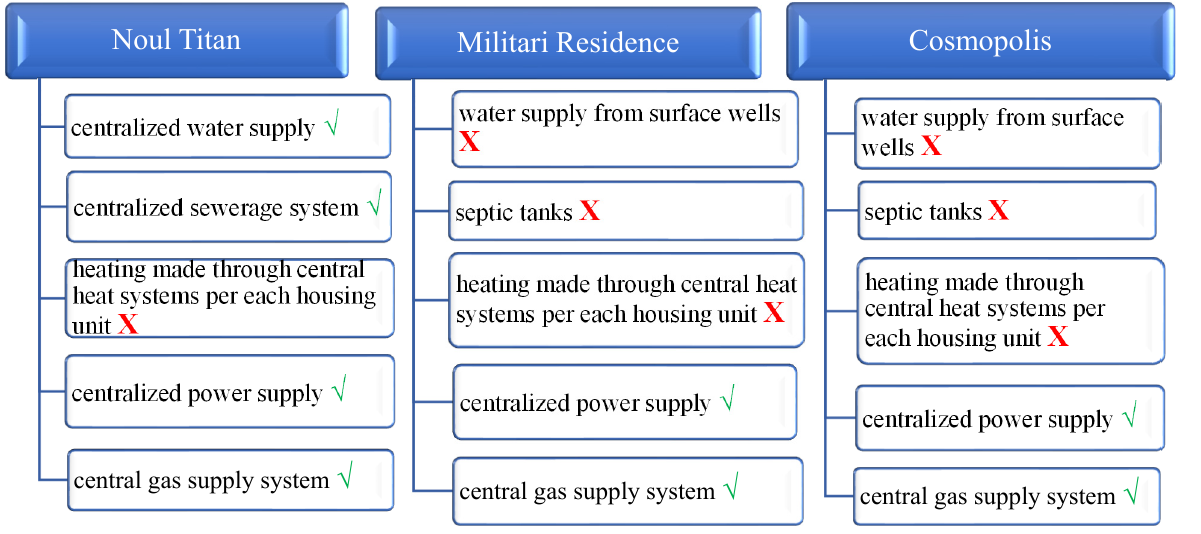
Figure 10. Comparative summary of the urban utilities in the three chosen residential nuclei (assets— √ vs. dysfunctionalities—X) based on data gathered from the observation sheets and the survey.